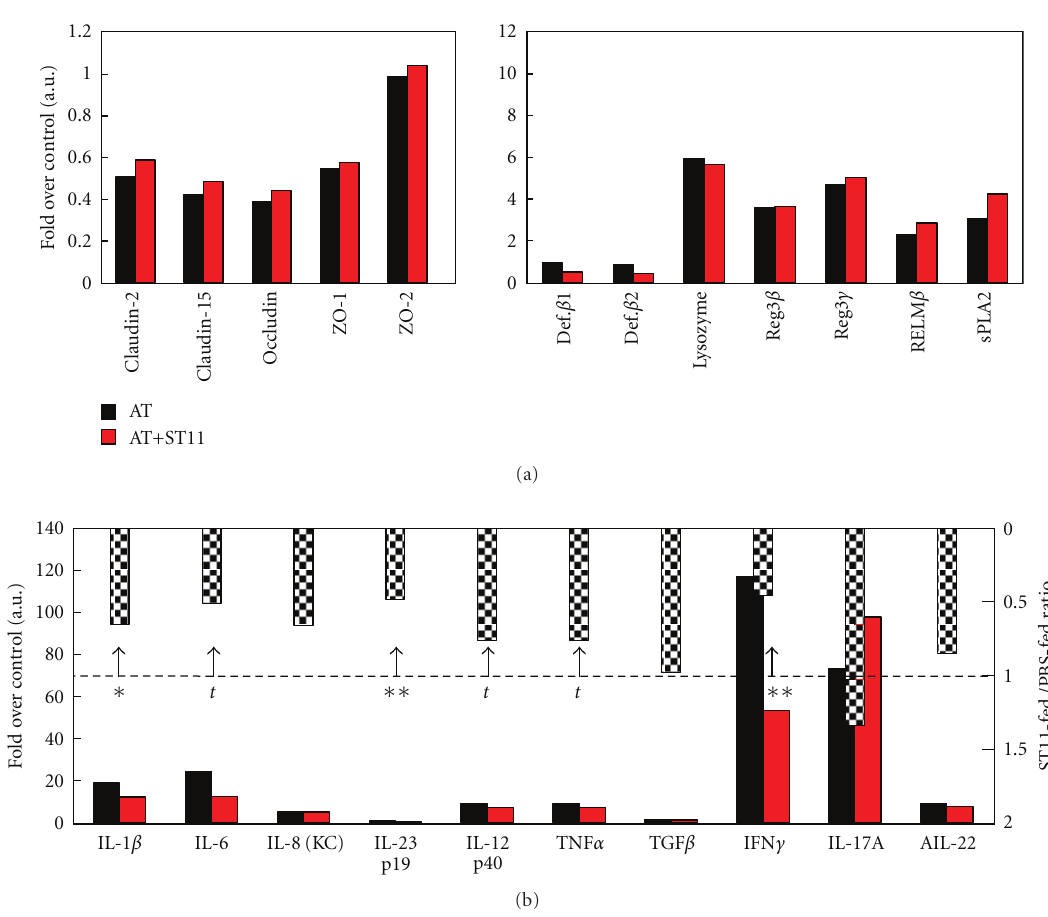
Figure 6: Gene expression analysis in colonic samples. Colonic mRNA expressions of tight junction proteins (Claudin-2, -15, occluding, ZO-1, and -2), antimicrobial peptides (defensin β -1, β -2, lysozyme, reg3 β , reg3 γ , RELM β , and secretory phospholipase A2), and cytokines (IL1 β , IL-6, IL-8, IL-12, IL-23, TNF α , TGF β , IFN γ , IL-17A, IL17F, and IL-22) were evaluated in PBS-fed or ST11-fed colitic mice and given in the lower red and black bar graphs, respectively. GAPDH was used as a reference gene. Ratios between ST11-fed and PBS-fed mice are shown in the upper inverted bar graphs, respectively. For a given gene, mRNA expression is either decreased when the ratio < 1 or increased when the ratio > 1 in ST11-fed animals. t : tendancy P = 0 . 064 ∗ , P < 0 . 05, and ∗∗ P < 0 . 01 versus PBS-fed